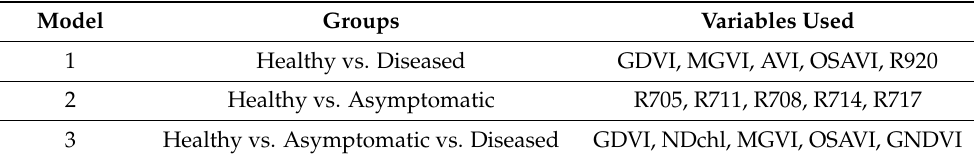
Table 2. Three classification model builds based on different combinations of relevant